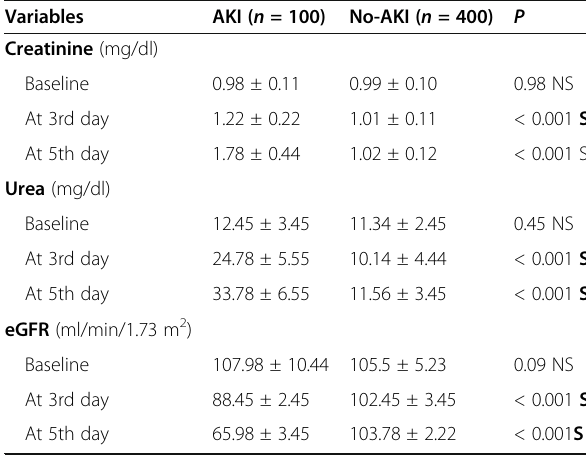
Table 3 Kidney function tests in studied patients based on development of acute kidney injury